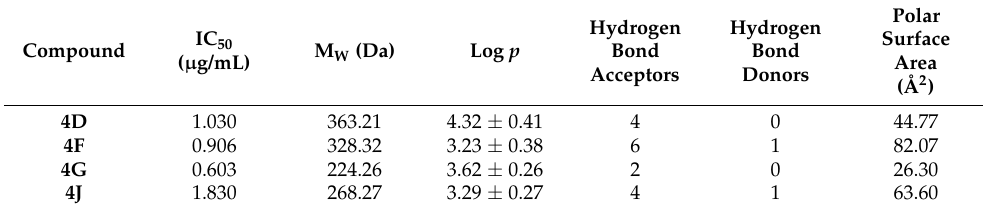
Table 4. Predictive analysis of drug-like